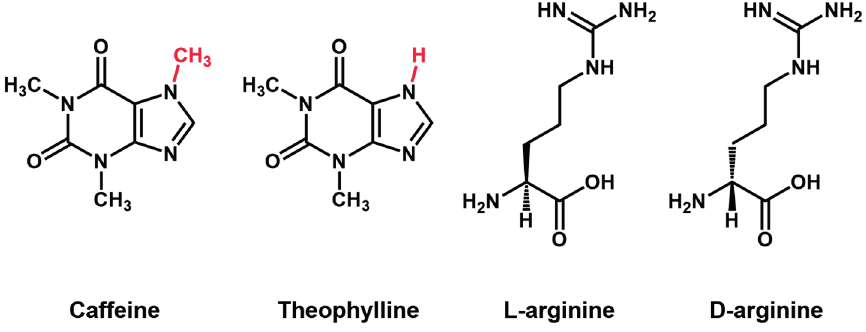
Figure 2. Chemical structure of theophylline, caffeine, L -arginine and D